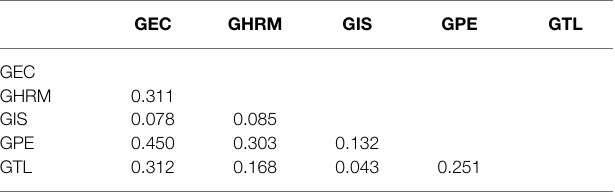
TABLE 6 | Heterotrait–Monotrait Ratio (HTMT). TABLE 3 | Cross loading.